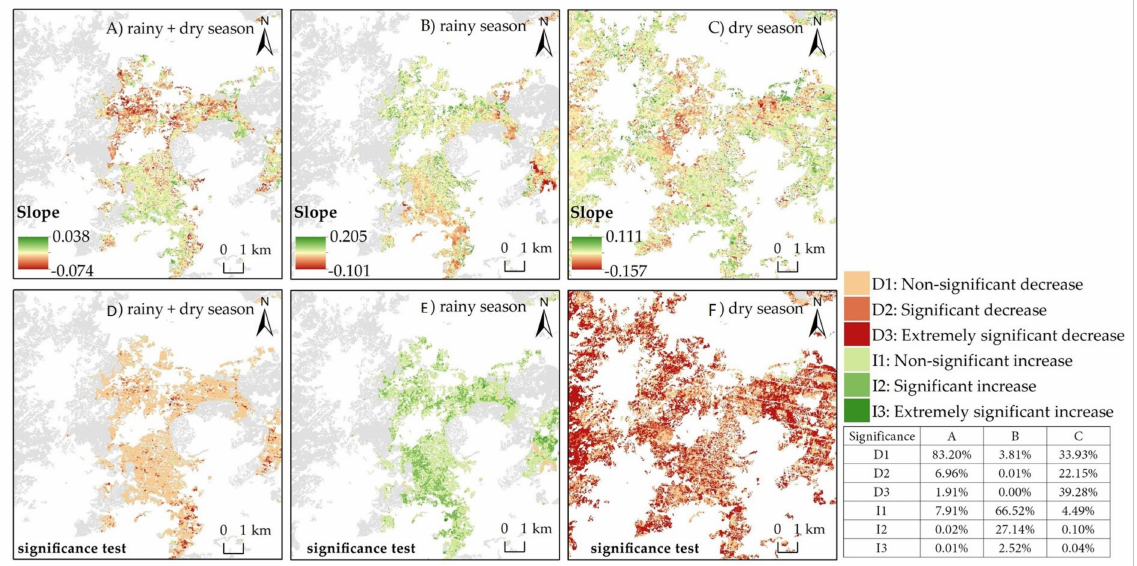
Figure 5. Slope and significance test results for rainy+dry season, rainy season, and dry